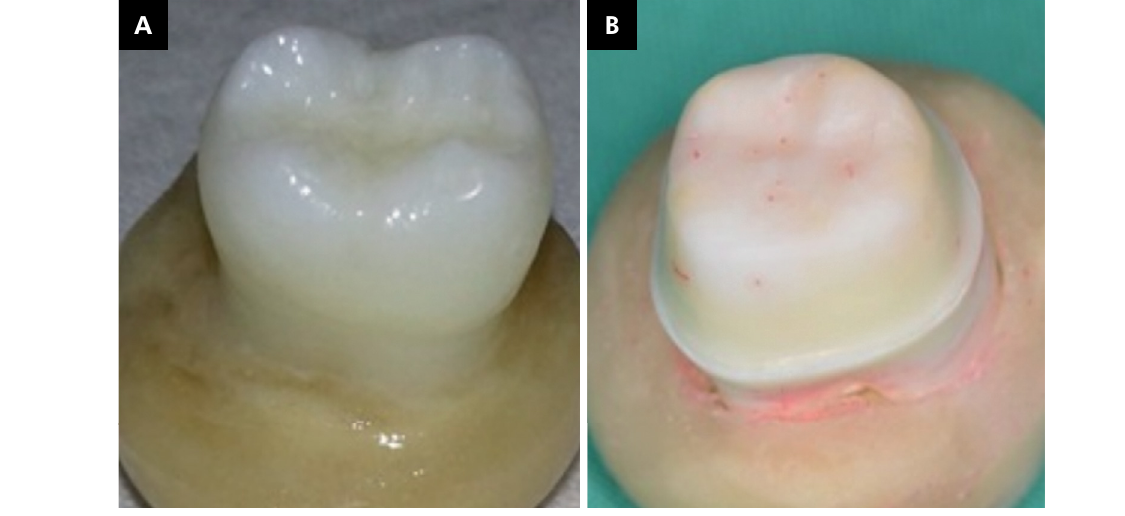
Figure 1. Extracted tooth in the acrylic base before and after preparation.